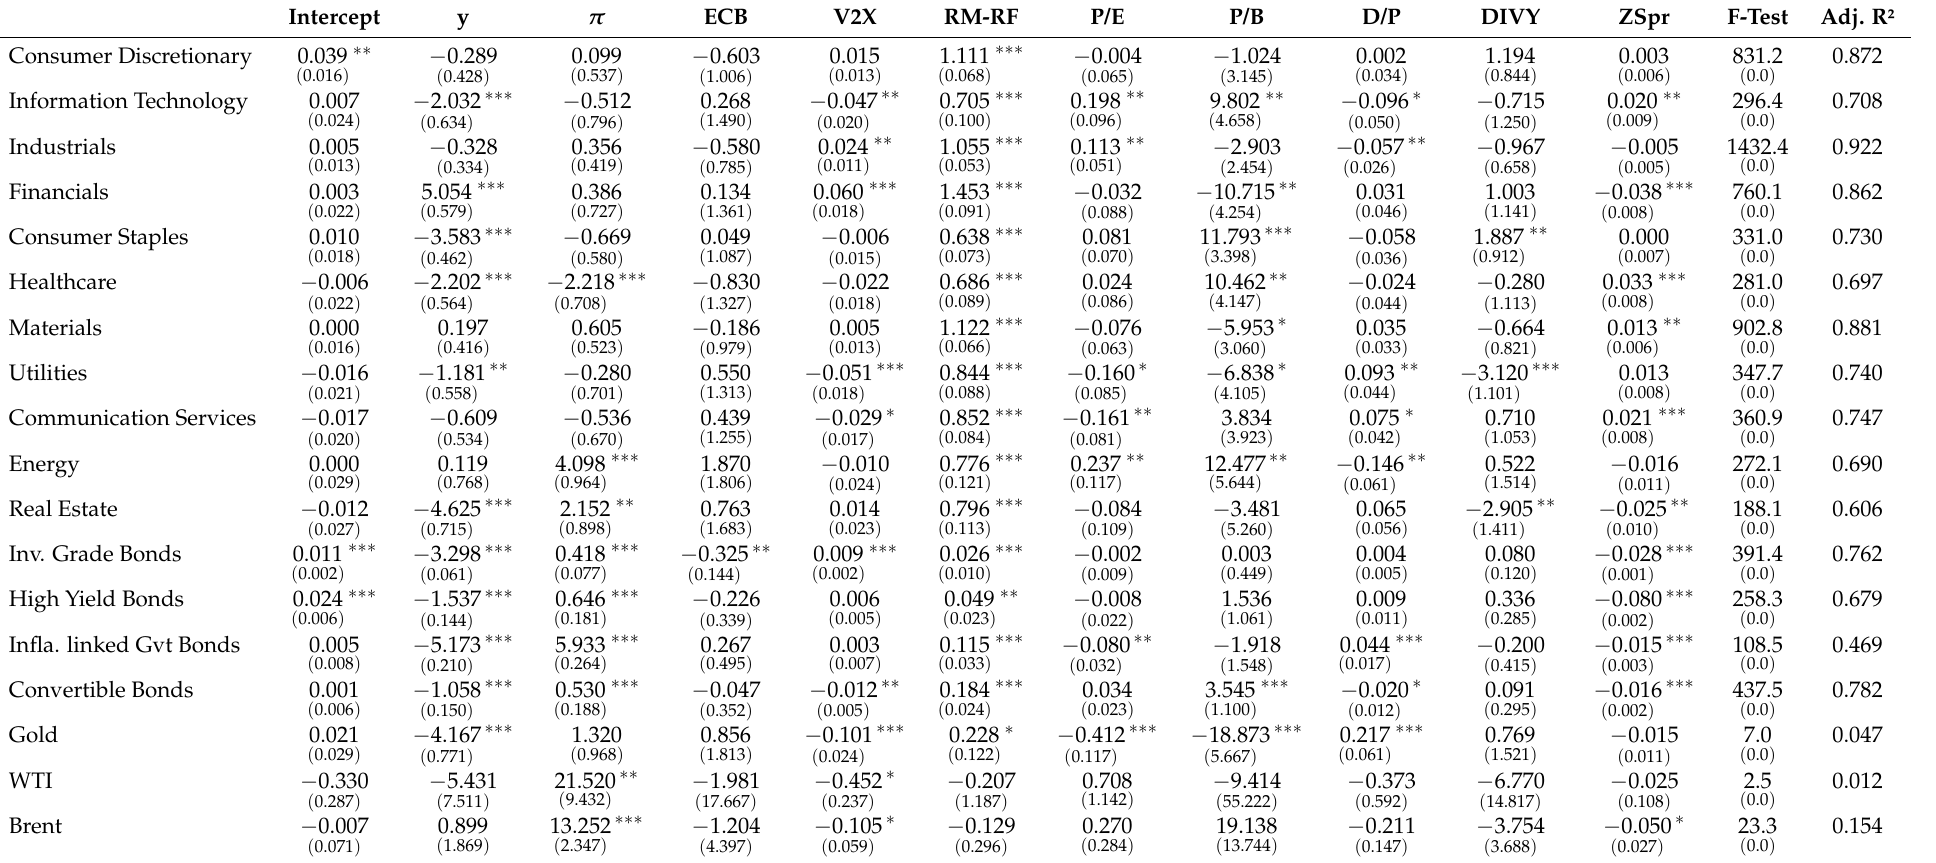
Table 7. Regression results for our panel under the high volatility regime of inflation expectations from 12 June 2009 to 02 November 2021. Error estimates are indicated in parentheses except for the F-Test, for which the p -value is in